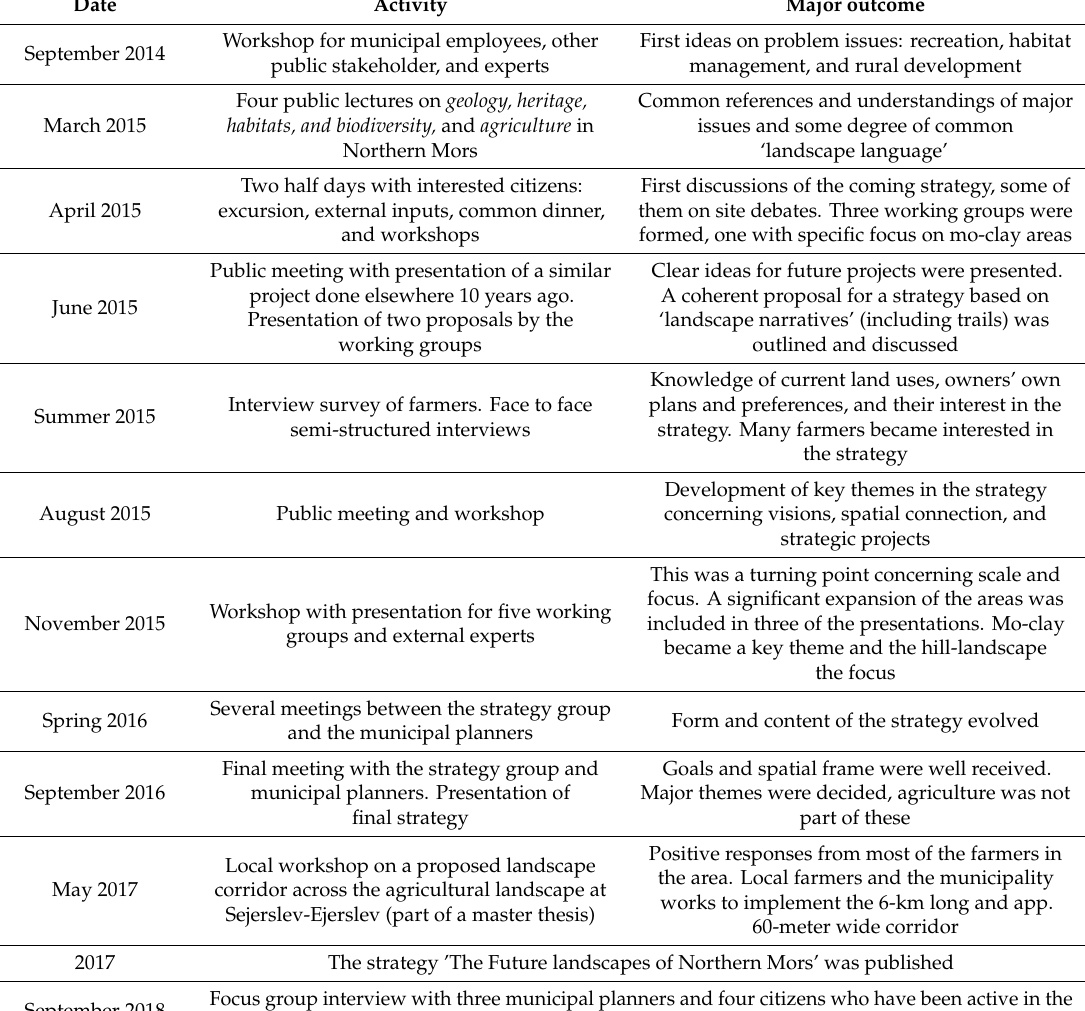
Table 1. Major activities in the landscape strategy process, the hills of Northern